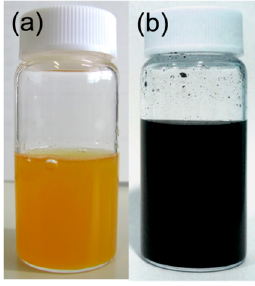
Figure 1. Photographs of pristine graphene oxide ( a ) and a Ru/graphene ( b ) nanocomposite.